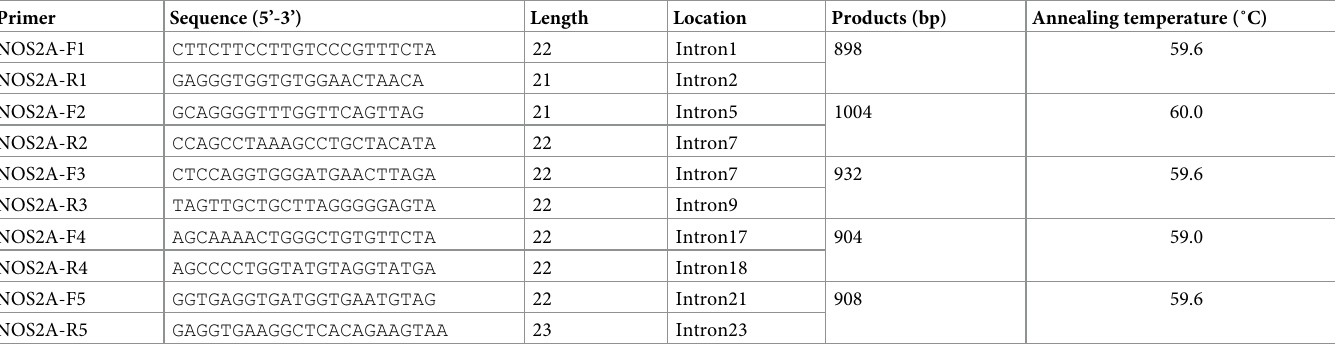
Table 1. Primer sequences for the NOS2A